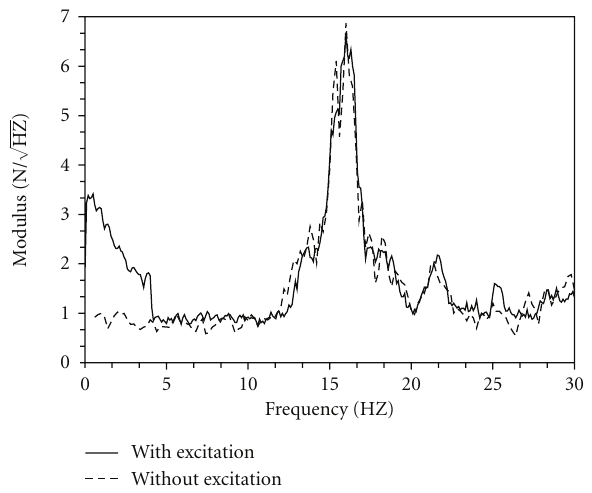
Figure 7: Square root of the autospectral density of f aligned versus frequency of with and without dynamic excitation, for a 4.2 m/s fluid velocity.